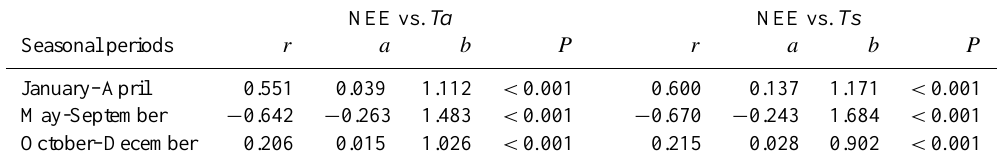
Table 5. Characteristics of linear regression analysis [ y = ax + b ] of daily net CO 2 ecosystem exchange (NEE, in µmolm − 2 d − 1 ) vs. monthly mean air temperature ( Ta , in ◦ C), and monthly mean soil temperature at the depth of 5cm ( Ts , in ◦ C) for different growth stage; data are from January 2004 to December 2006.